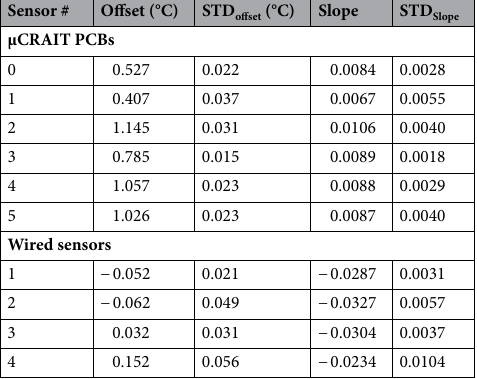
Table 2. µCRAIT box and sample rack temperature uniformity characterization. For µCRAIT box, the sensors 1–4 were located at bottom, mid-bottom, middle and top of the stick. For the dummy sample rack, the sensors 1–4 were located at outside short edge, inside center, outside bottom and inside long edge of the rack.